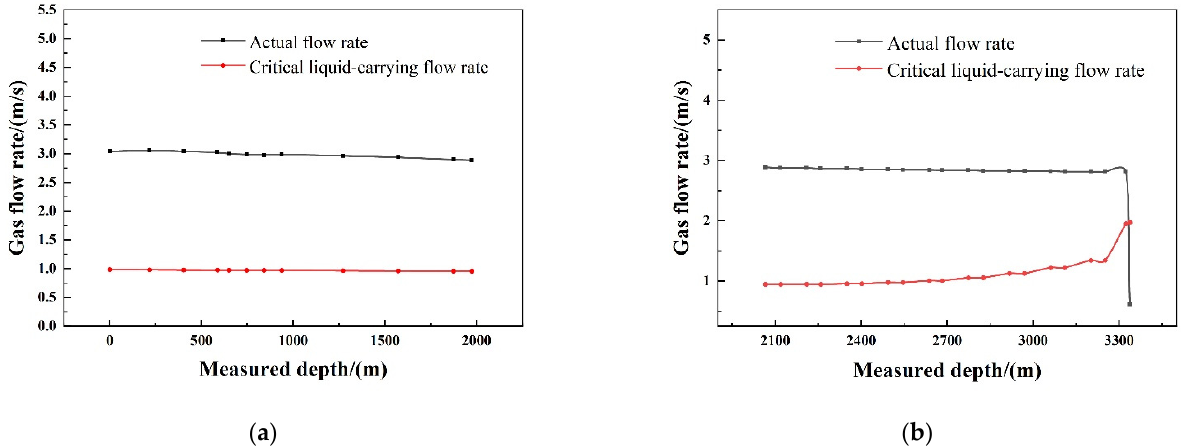
Figure 7. ( a ) Actual gas flow rate and critical liquid-carrying flow rate in the vertical section. ( b ) Actual gas flow rate and critical liquid-carrying flow rate in the inclined section. Table 2. Tubing, casing dimensions, and running